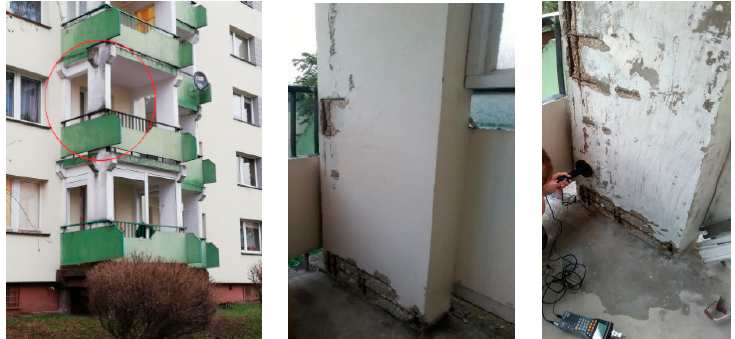
Figure 1. The analyzed precast reinforced concrete wall.